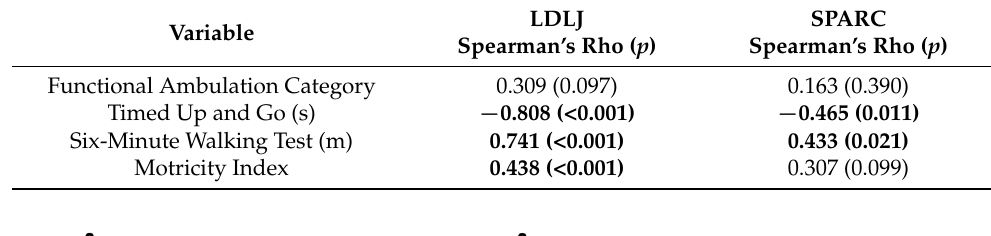
Table 3. Spearman’s rank correlation coefficient (Spearman’s rho) and p -values between the clinical scales and the two metrics of smoothness (log dimensionless jerk, LDLJ, and spectral arc length, SPARC). Values in bold indicate a statistically significant correlation ( p < 0.05).